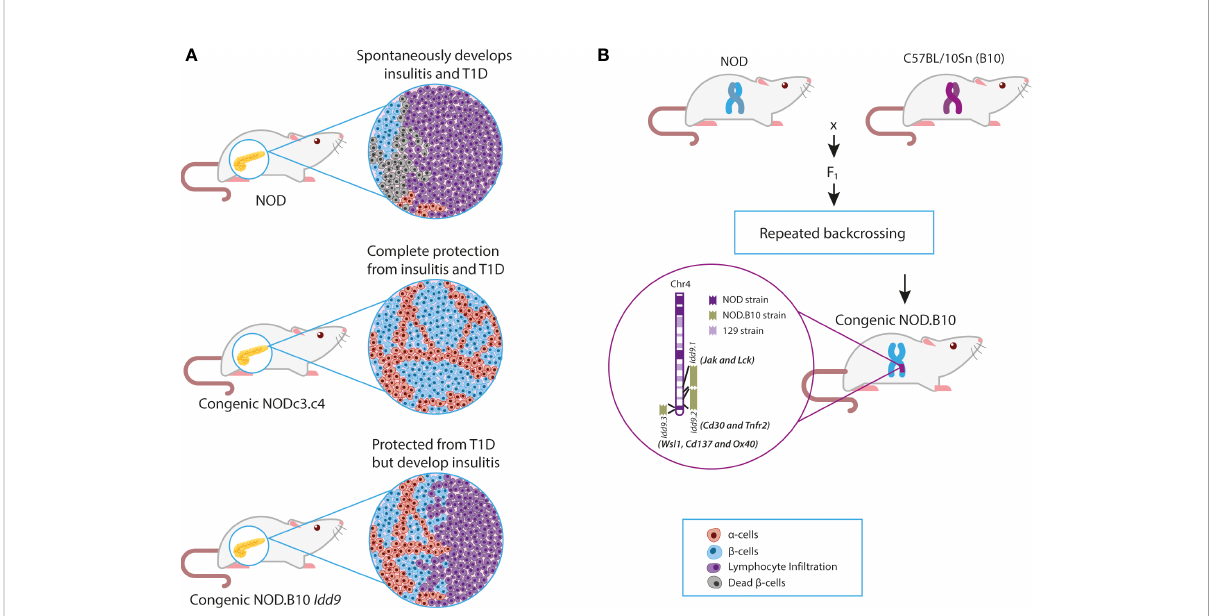
FIGURE 1 NOD and NOD Congenic mice. (A) Effects of congenic intervals on the clinical and histological phenotypes of NOD mice. (B) Breeding of NOD and B10 mice to produce congenic mice with Idd9 regions. Chr, Chromosome; NOD, Non-obese diabetic; T1D, Type 1